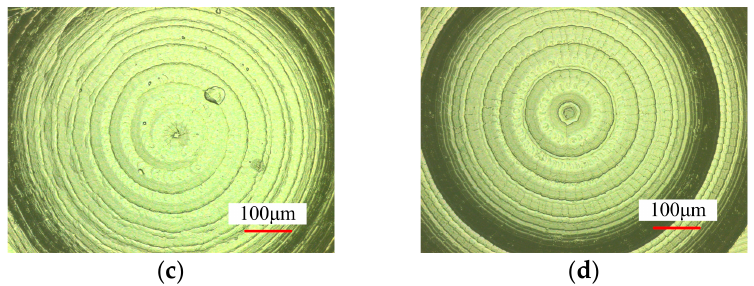
Figure 11. Surface morphology of the hot embossed micro-lens array mold. ( a ) Single direction raster; ( b ) raster; ( c ) 3D offset spiral; and ( d ) equal height finish.